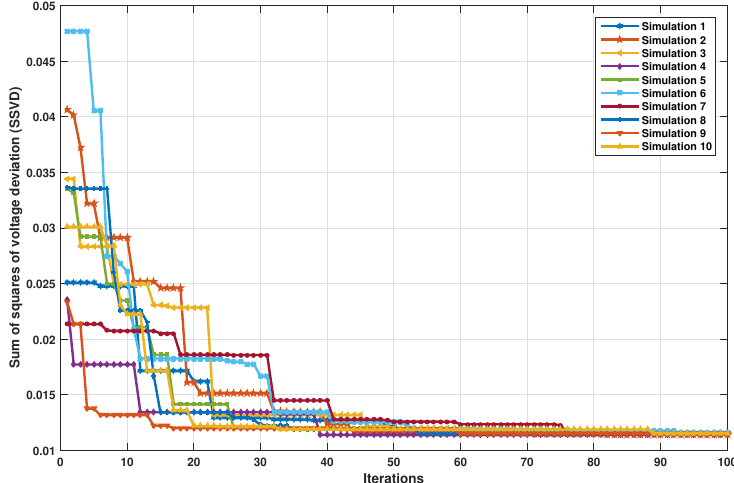
Figure 5. PG and E 69 bus system: Convergence characteristics.